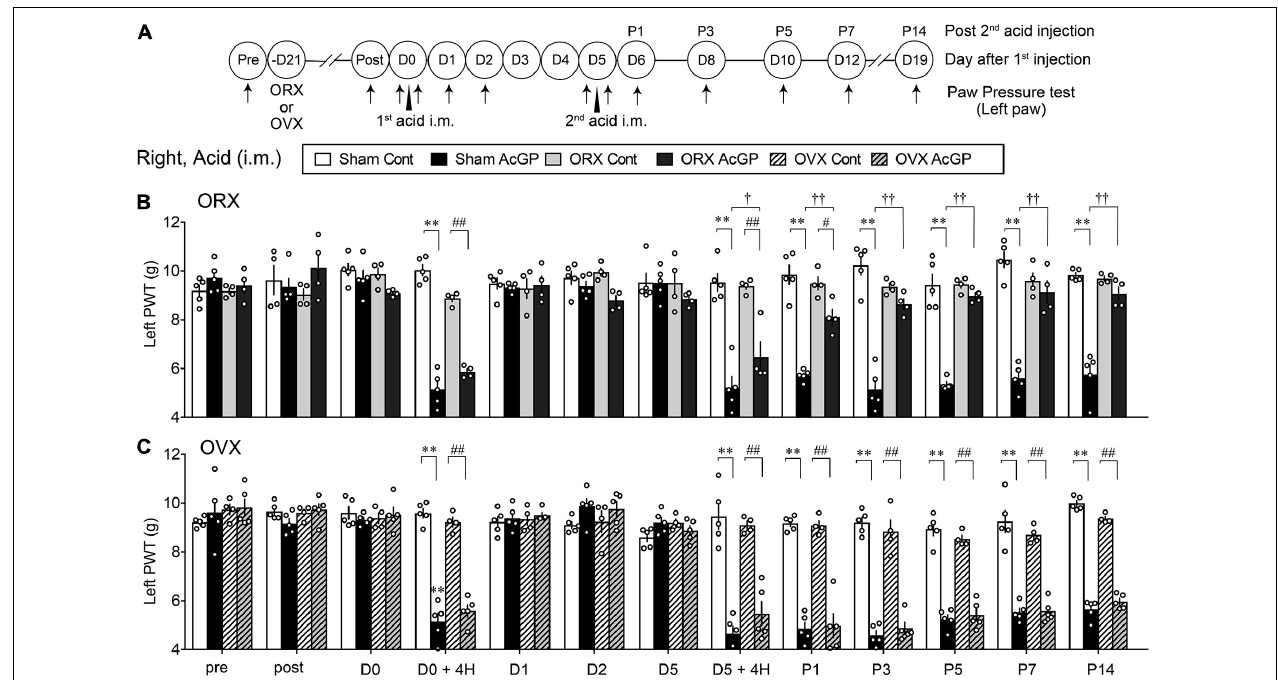
FIGURE 2 | Male-specific blockade of contralateral AcGP by gonadectomy. (A) The surgical operation of orchiectomy or ovariectomy was performed 3 weeks before the first acid saline injection. Time points of acid saline injection into “Right” muscle and paw pressure test at the left paw were indicated by arrowheads and arrows, respectively. (B,C) Sexual dimorphic effects of ORX (B) and OVX (C) on the long-lasting mechanical allodynia after the second acid saline injection. Results represent the nociceptive paw withdrawal threshold (PWT in g) on the left side in the paw pressure test after the right acid saline injection (i.m.) in sham-operated or gonadal removed mice. Data at “post” were obtained at the day of 3 weeks after the gonadectomy. ∗∗ p < 0.01, compared with each time point at Sham Cont, # p < 0.05; ## p < 0.01, compared with each time point at ORX Cont (B) or OVX Cont (C) , † p < 0.05; †† p < 0.01, compared with each time point at Sham AcGP, in two-way repeated measures ANOVA followed by Tukey’s multiple comparisons test (Sham Cont, n = 4–5; Sham AcGP, n = 5; ORX Cont, n = 4, ORX Acid, n = 4; OVX Cont, n = 4; and OVX AcGP, n = 5). The dots in the column represent number of animals. AcGP, acid saline-induced FM-like generalized pain; ORX, orchiectomy; OVX,